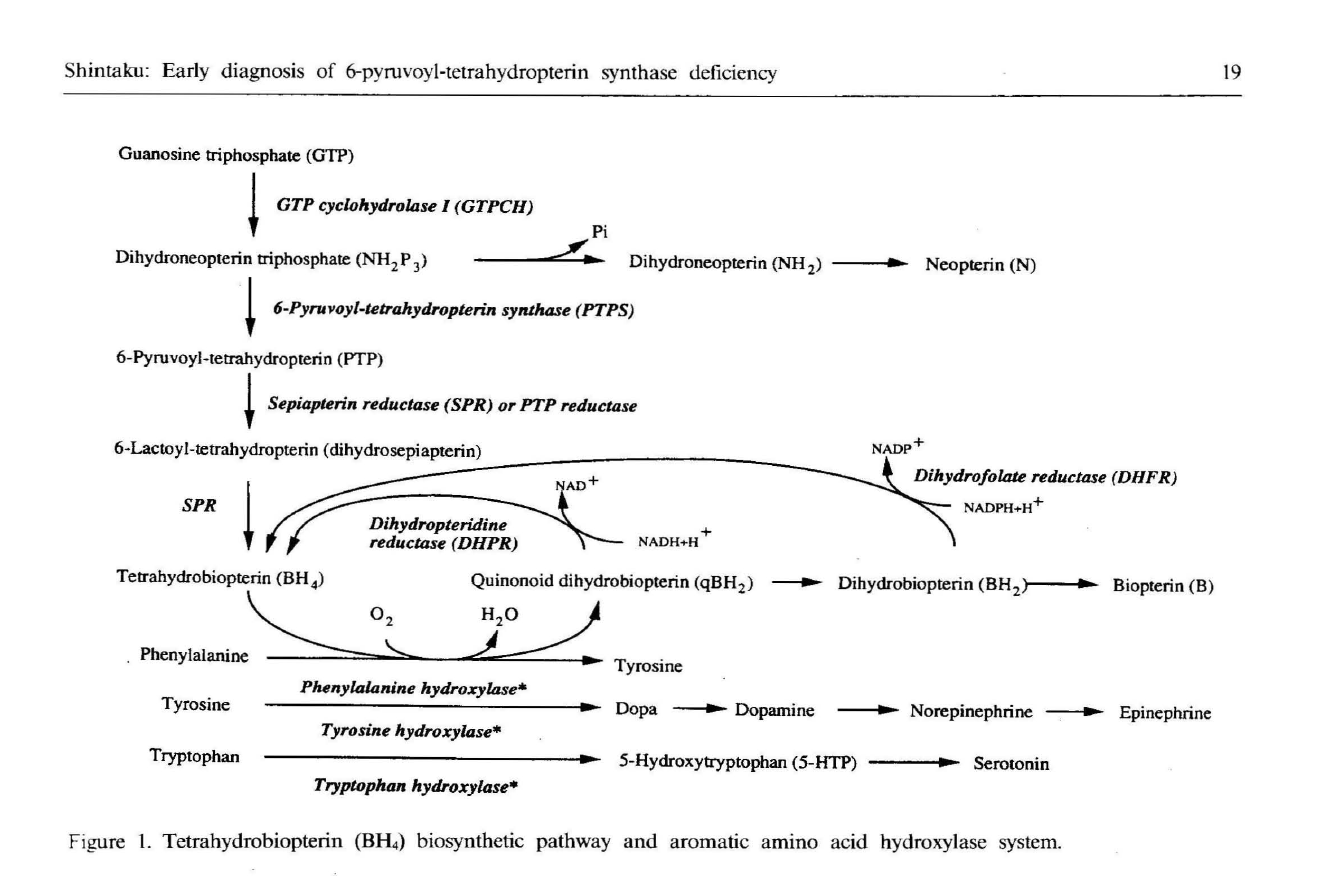
ylase (3), and later it was found that BH4 is a cofac ror of tyrosine 3-hydroxylase (EC 1.14.16.2) and tryp tophan 5-hydroxylase (EC 1.14.16.4), as well (5, 6). i Fig.